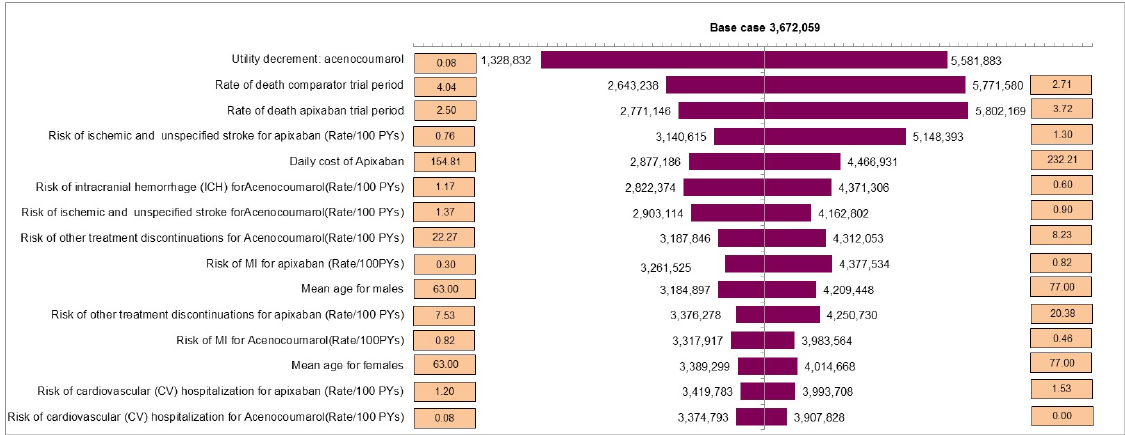
Figure 2b. Tornado Chart for Apixaban versus Acenocoumarol in the VKA-suitable Population (ICER)*